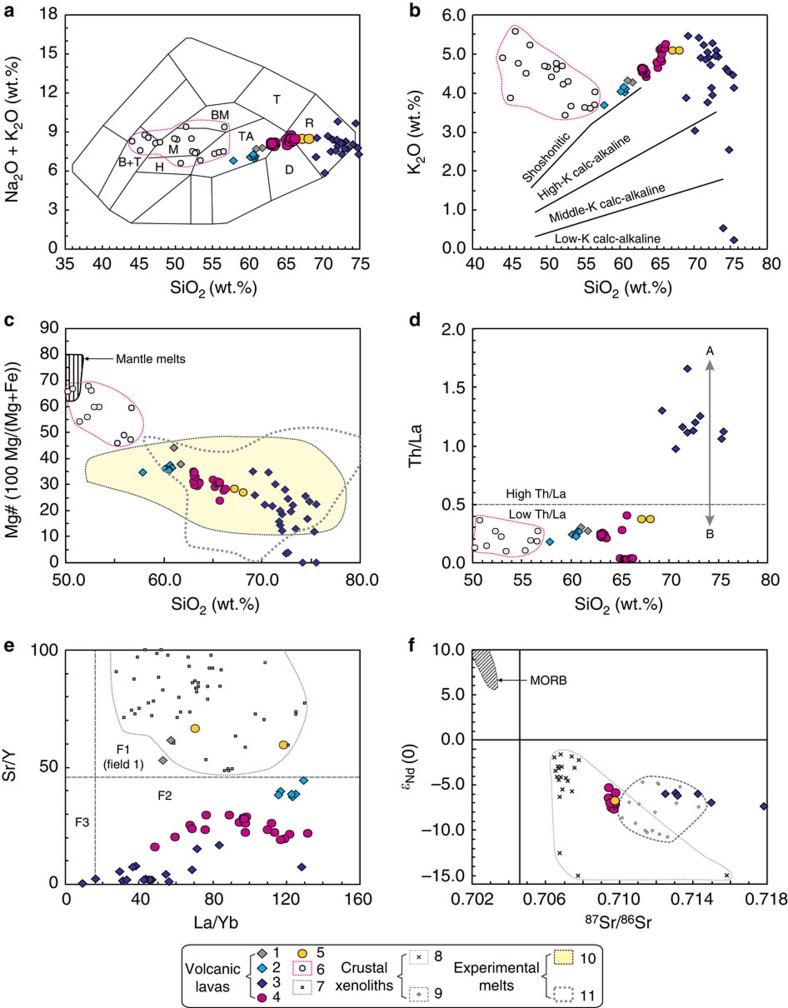
Geochemical diagrams for Late Cenozoic lavas from central and northern Tibet.Units 1–5 are the Pliocene-Quaternary (4.7–0.3 Myr ago) felsic volcanic lavas of central and northern Tibet, with the same key as for Fig. 4. The geochemical data are from Supplementary Data set 1. 6, Miocene (18–13 Myr ago) and Pliocene-Quaternary (5.0–0.07 Myr ago) potassic–ultrapotassic mafic rocks in northern Tibet531; 7, the central and northern Tibetan 47–15 Myr ago adakitic rocks3233; 8, granulite xenoliths from 3.8 Myr ago lavas of the Wulanwulahu area of the Qiangtang Block (Supplementary Table 1); 9, garnet-bearing mafic granulite and amphibolite xenoliths from 28 Myr ago intrusive rocks in the Hoh Xil area of Songpan-Ganzi, northern Tibet (Supplementary Table 1). Experimental melts: 10, metabasaltic and eclogite experimental melts (1–4.0 GPa) (after Wang et al.67); 11, metabasaltic experimental melts (0.1–0.8 GPa)404368. (a) SiO2 versus K2O+Na2O (after Cox et al.69). Rock types: B+T, basanite and tephrite; BM, benmorite; D, dacite; H, hawaiite; M, mugearite; R, rhyolite; T, trachyte; TA, trachyandesite. (b) SiO2 versus K2O. The Pliocene-Quaternary (4.7–0.3 Myr ago) felsic lavas plot on a different trend from northern Tibetan potassic–ultrapotassic mafic rocks. (c) SiO2 versus Mg#. The field for mantle melts is after Wang et al.67. The Pliocene-Quaternary (4.7–0.3 Myr ago) felsic lava samples have Mg# lower than the northern Tibetan potassic–ultrapotassic mafic rocks but similar to experimental melts. (d) SiO2 versus Th/La. High-Th/La ratios in magmatic rocks indicate relatively large contributions from sedimentary source rocks323639. ‘A' indicates partial melting of sediment-dominated crustal sources and ‘B' reflects partial melting of more mafic crustal sources. (e) La/Yb versus Sr/Y diagram. This diagram indicates the effects of residual garnet (Grt) and plagioclase (Pl) during partial melting (for discussion see the text). F1 (Field 1), adakitic melts derived from eclogitic rocks in the stability field of Grt with little or no Pl; F2 (Field 2), crustal melts in the stability field of Pl and Grt; F3 (Field 3), crustal melts in the stability field of Pl with little or no Grt. (f) 87Sr/86Sr versus ɛNd(0) diagram. The field for MORB (middle oceanic ridge basalt) is after Wang et al.67.